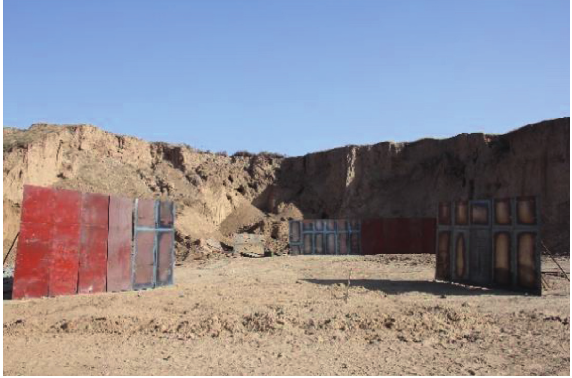
Figure 2: Schematic diagram of test